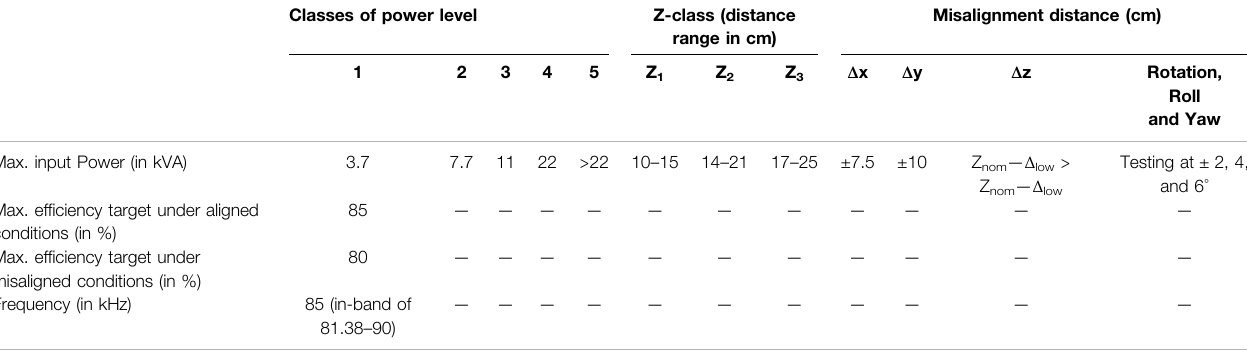
TABLE 4 | SAE J2954 vehicle power levels (SAE International, 2020). Classes of power level